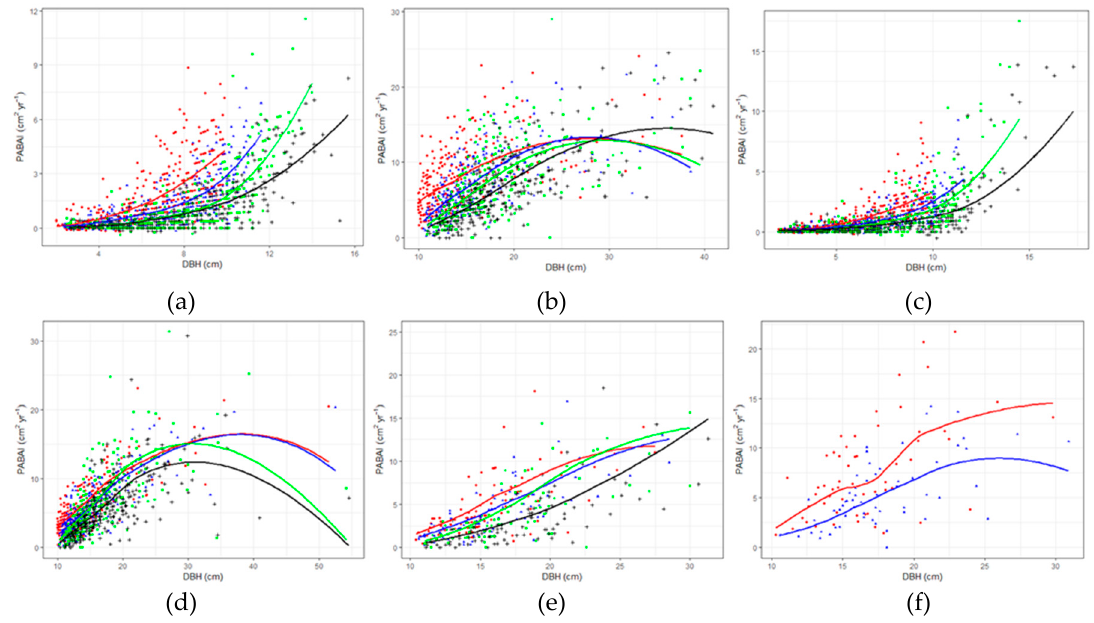
Figure 3. Predicted periodic annual basal area increment versus DBH using the fixed effects parameters of the equation with partitioned CI (Equation 9) for: ( a ) small interior Douglas fir in Block C; ( b ) large interior Douglas-fir in Block C; ( c ) small interior Douglas fir in Block D; ( d ) large interior Douglas-fir in Block D; ( e ) large spruce in Block D; and ( f ) large PL in Block D. The red, blue, green, and black lines represent the predicted PABAI for 1993–1997, 1997–2004, 2004–2008, and 2008–2013 growth periods, respectively. The red, blue, green, and black symbols represent the measured PABAI values for the same periods.